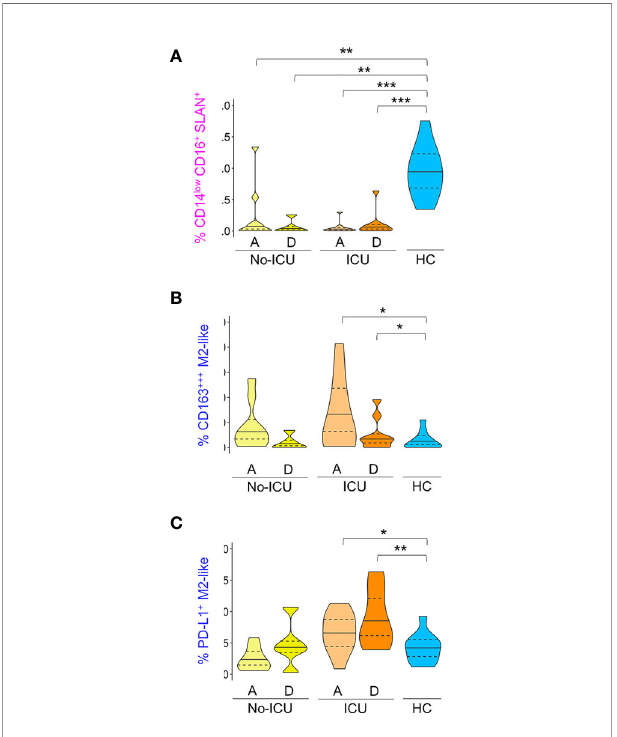
FIGURE 2 | M2-like and Slan+ monocyte clusters in COVID-19 . Frequency of clusters, manually annotated, identi fi ed using X-Shift within total CD45+ Lin − cells: (A) In pink: CD14lowCD16+Slan+; (B) In dark blue: CD163+++ M2-like; (C) In dark blue: PD-L1+M2-like. Comparisons were performed between patient groups and healthy controls using Mann – Whitney U-test. p values are shown as ***p < 0,001; **p < 0,01; *p < 0,05 . No statistical differences were found between patient groups. ICU, Intensive care unit; A, admission; D, Discharge; HCs, Healthy